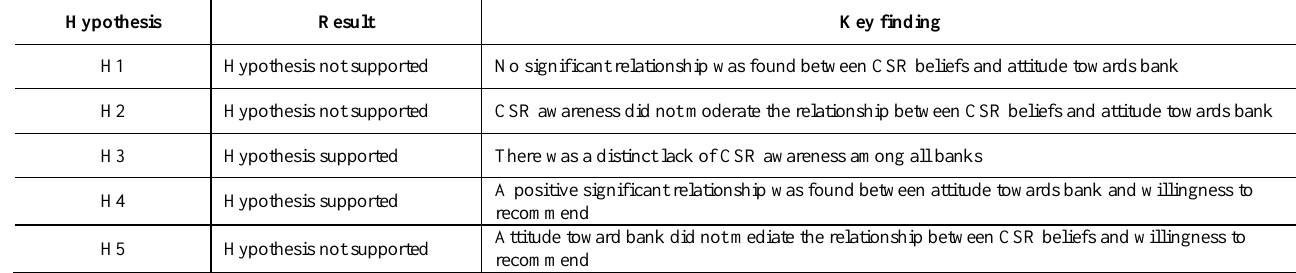
Table 4: Summary of hypothesis verification outcome Hypothesis